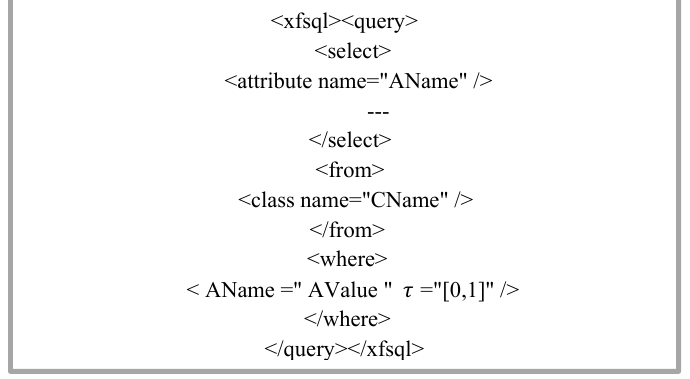
Fig. 4. Select syntax with XML